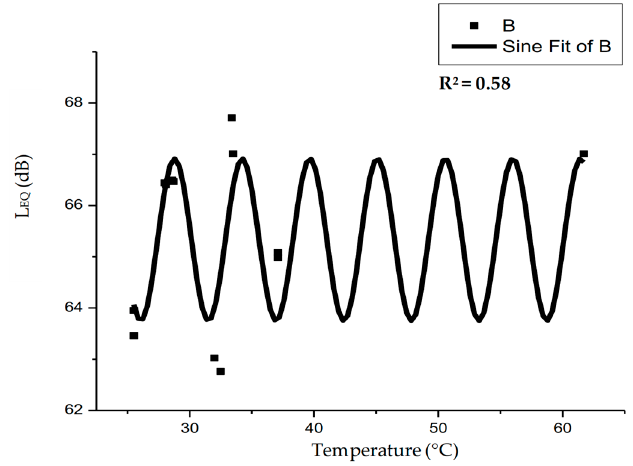
Figure 9. Correlation modeling between Temperature and Noise Level at OW-T. Buildings 2018 , 8 , x FOR PEER REVIEW Table 13. Correlation modeling between Temperature and Noise Level at OW-L